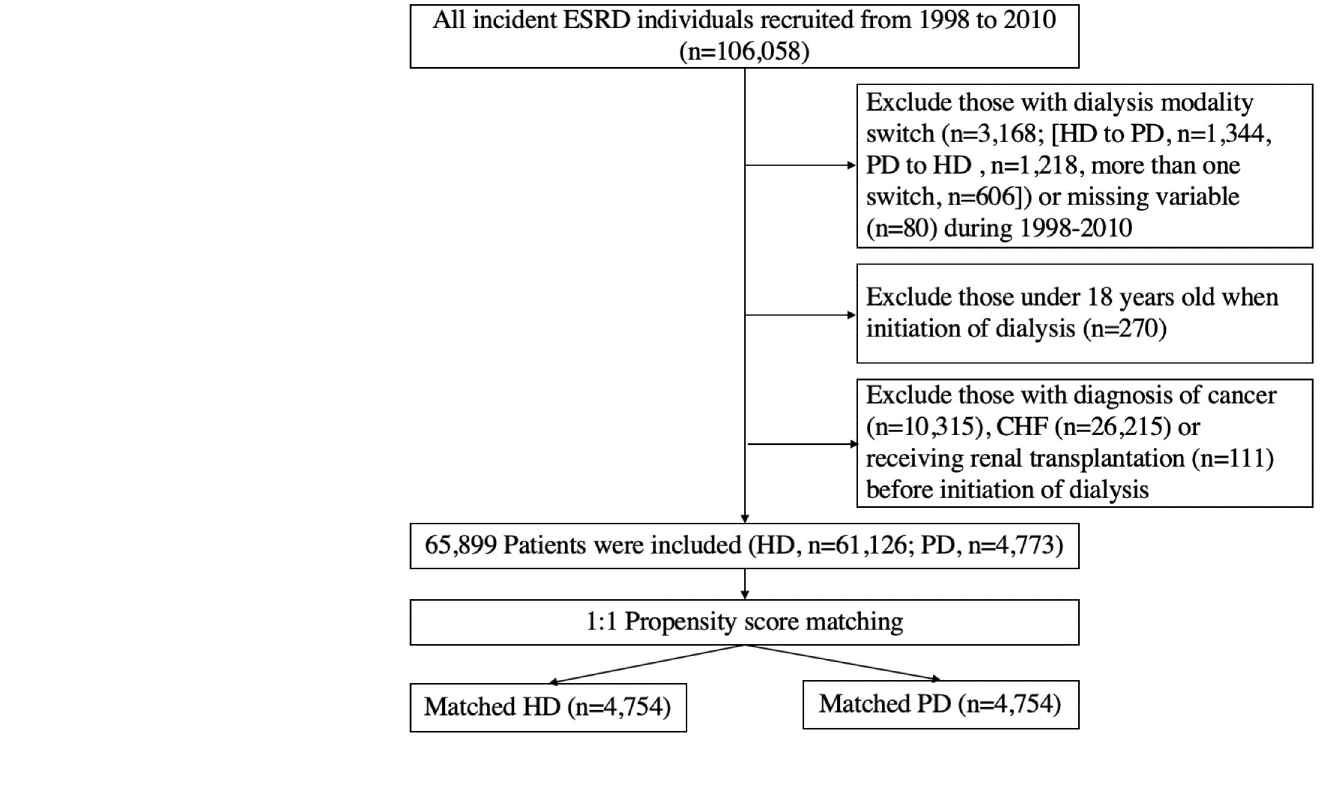
Fig 1. Flow chart of the establishment of matched-pairs of dialysis patients receiving hemodialysis or peritoneal dialysis.